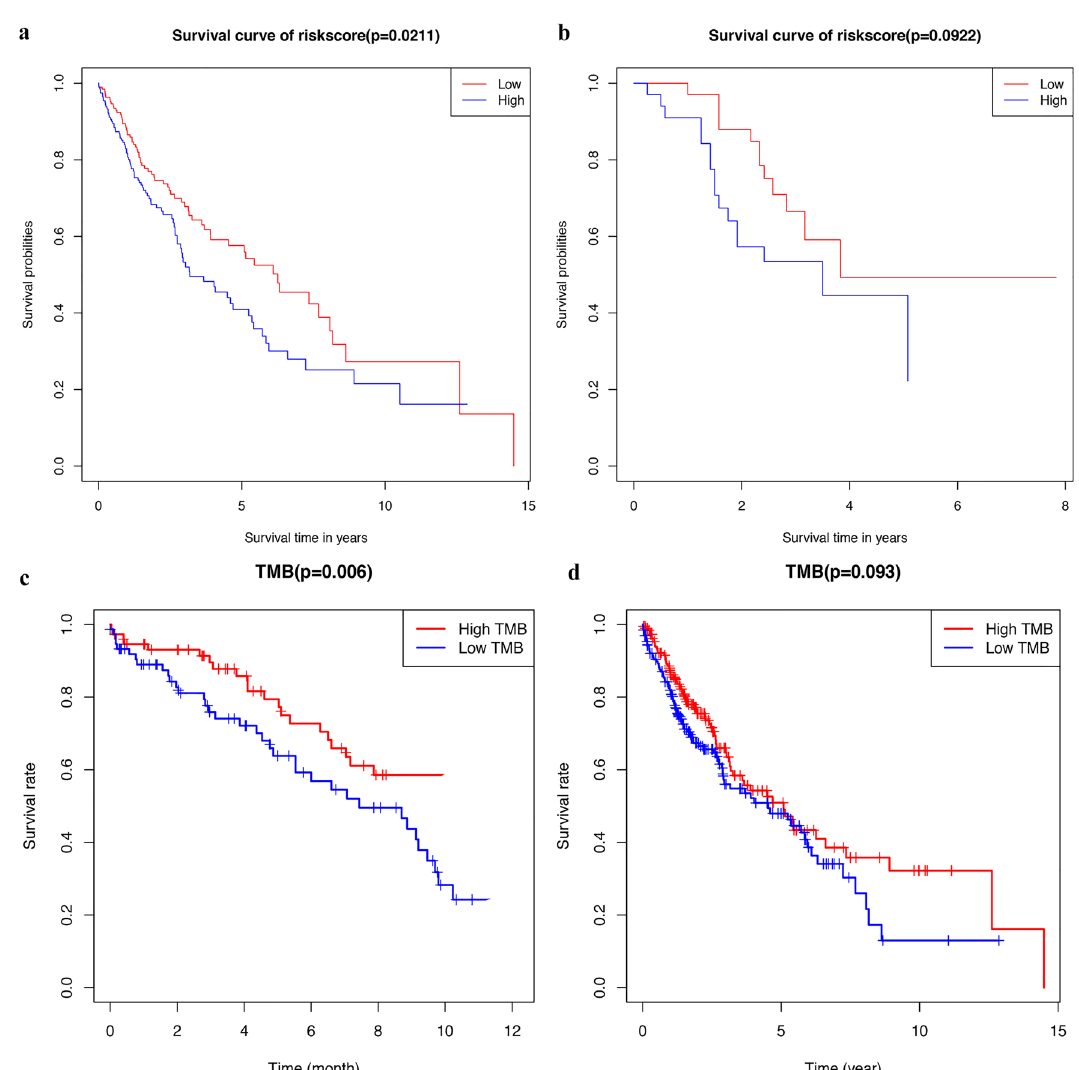
Figure 5. Kaplan–Meier survival curves. ( a / b ) Patients from the TCGA and GSE73403 dataset are stratified into two groups according to median values for the risk scores calculated by three gene based on risk score signature. ( a ) Kaplan–Meier survival curves of the signature in TCGA dataset. ( b ) Kaplan–Meier survival curves of the signature in GSE73403 dataset. ( c ) Kaplan–Meier survival curves of different TMB groups calculated by VarScan. ( d ) Kaplan–Meier survival curves of different TMB groups calculated by MuTect. (Red means high- TMB group and blue means low-TMB